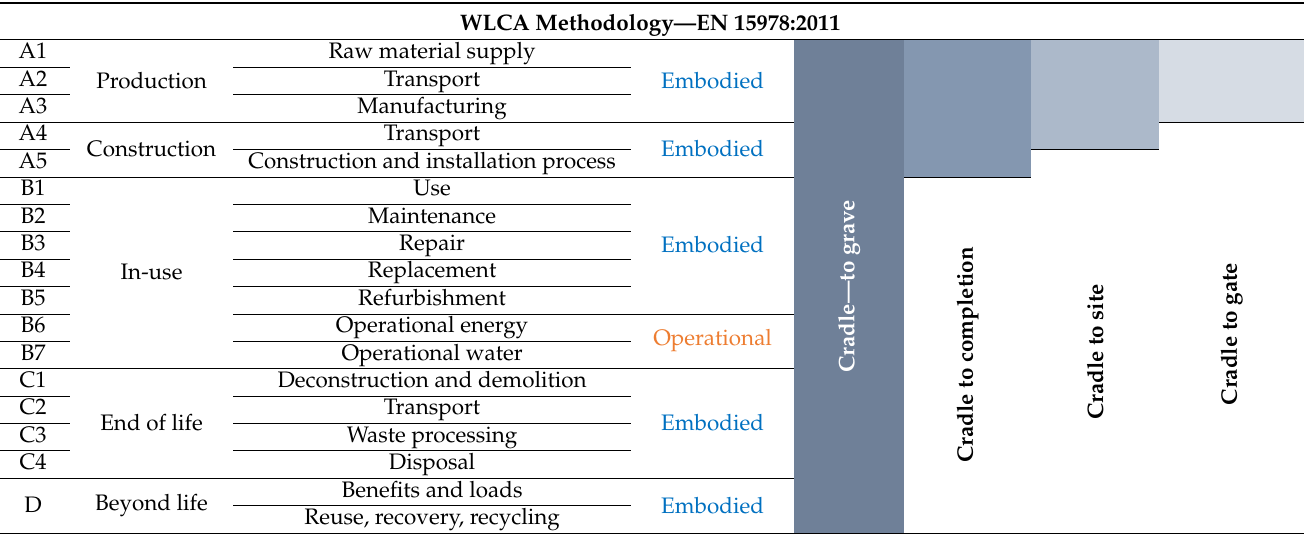
Table 1. Whole-life carbon assessment (WLCA) calculation methodology as defined by EN15978:2011. Emissions are unpacked into four modules to highlight where emissions come from. WLCA Methodology—EN